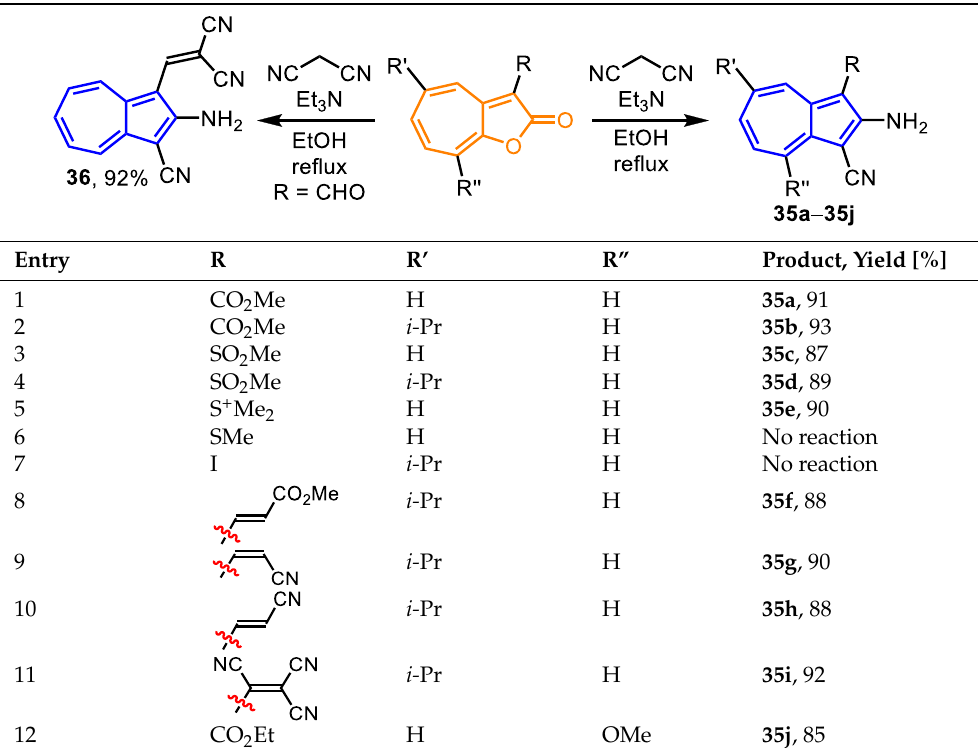
Table 1. Reaction of 2 H -cyclohepta[ b ]furan-2-ones with active methylenes.